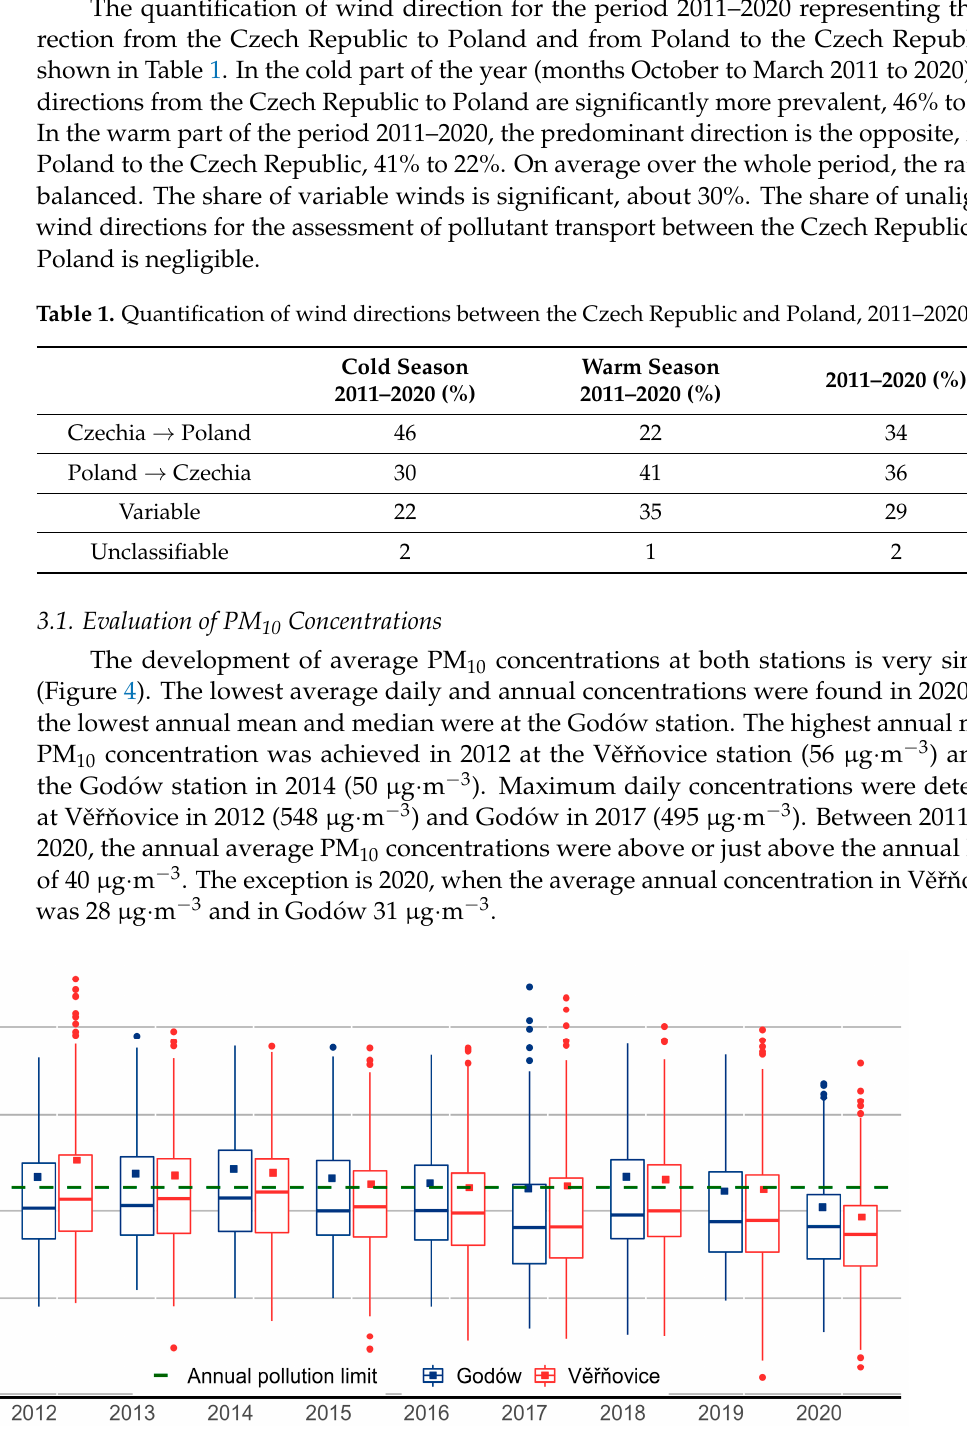
Figure 5. Regression dependences between average daily PM 10 concentrations, Godów and V ěřň ov- ice stations, 2011–2020 [µg ∙ m − 3 ]. The weighted concentration roses for PM 10 at the V ěřň ovice site (Figures 6 and 7) show that the most frequent average contributions of PM 10 concentrations come at the station from the NE to E direction at wind speeds up to 2 m ∙ s − 1 . The highest PM 10 concen- trations are obtained in the cold months of the year. More illustrative is Figure 7, which does not include wind speed information. The maximum 1-h contributions at the V ěřň ov- ice station (Figure 8) come from the NE and up to E directions at low wind speeds around 1 m ∙ s − 1 . The SW direction is the predominant flow direction at the station, but lower aver- age PM 10 concentrations come from this direction. High contributions of maximum short- term PM 10 concentrations are also not recorded from the SW direction.